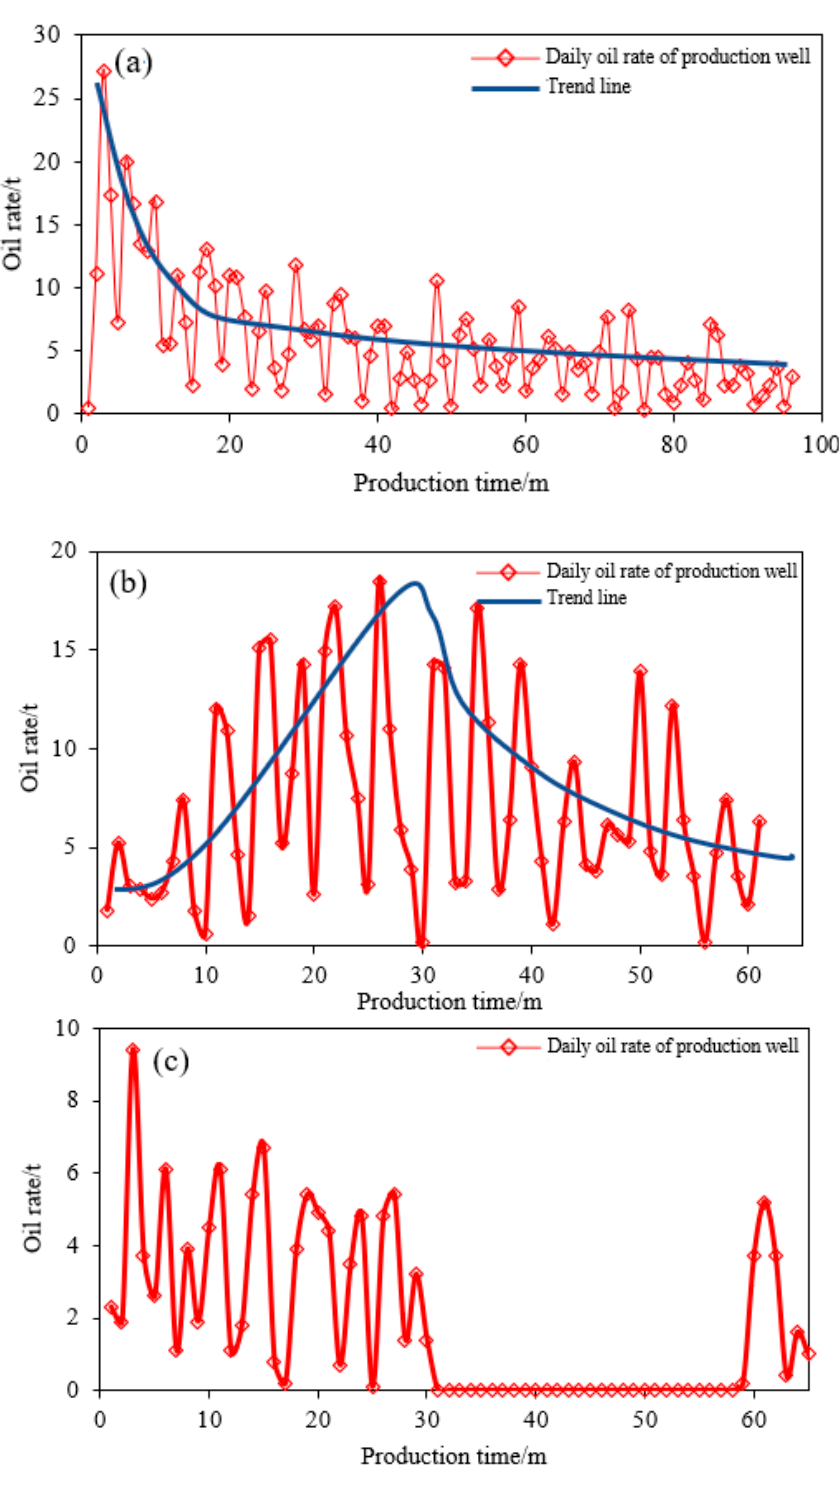
Figure 7. The production performance of three categories of wells. ( a ) The wells of relatively initial high oil production rates and subsequent sharply decreasing trends. ( b ) The wells of a gradual climbing trend of oil rates in the initial cycles and then a decreasing trend. ( c ) The wells of relatively low oil rates throughout the production life